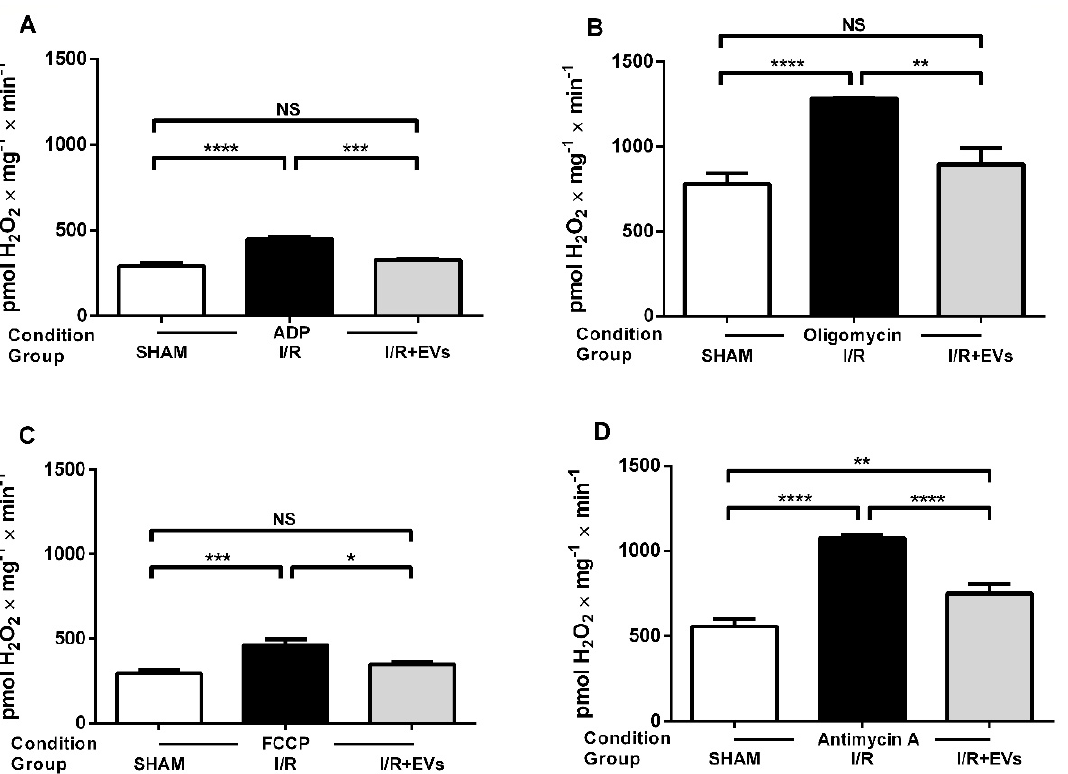
Figure 4. Quantification of H 2 O 2 formation (energization with succinate) 24 h after I/R. Assays were carried out in the different respiratory states indicated on the abscissae. ( A ) Phosphorylating (1 mM ADP). ( B ) Non-phosphorylating (oligomycin). ( C ) Uncoupled (FCCP). ( D ) Residual (Antimycin A). Experimental groups are also indicated on the abscissae. Bars indicate mean ± SEM of the number of determinations indicated in the legend to Figure 3. * p < 0.05; ** p < 0.01; *** p < 0.001; **** p < 0.0001; NS: not significant (one-way ANOVA followed by Tukey ´ s test).